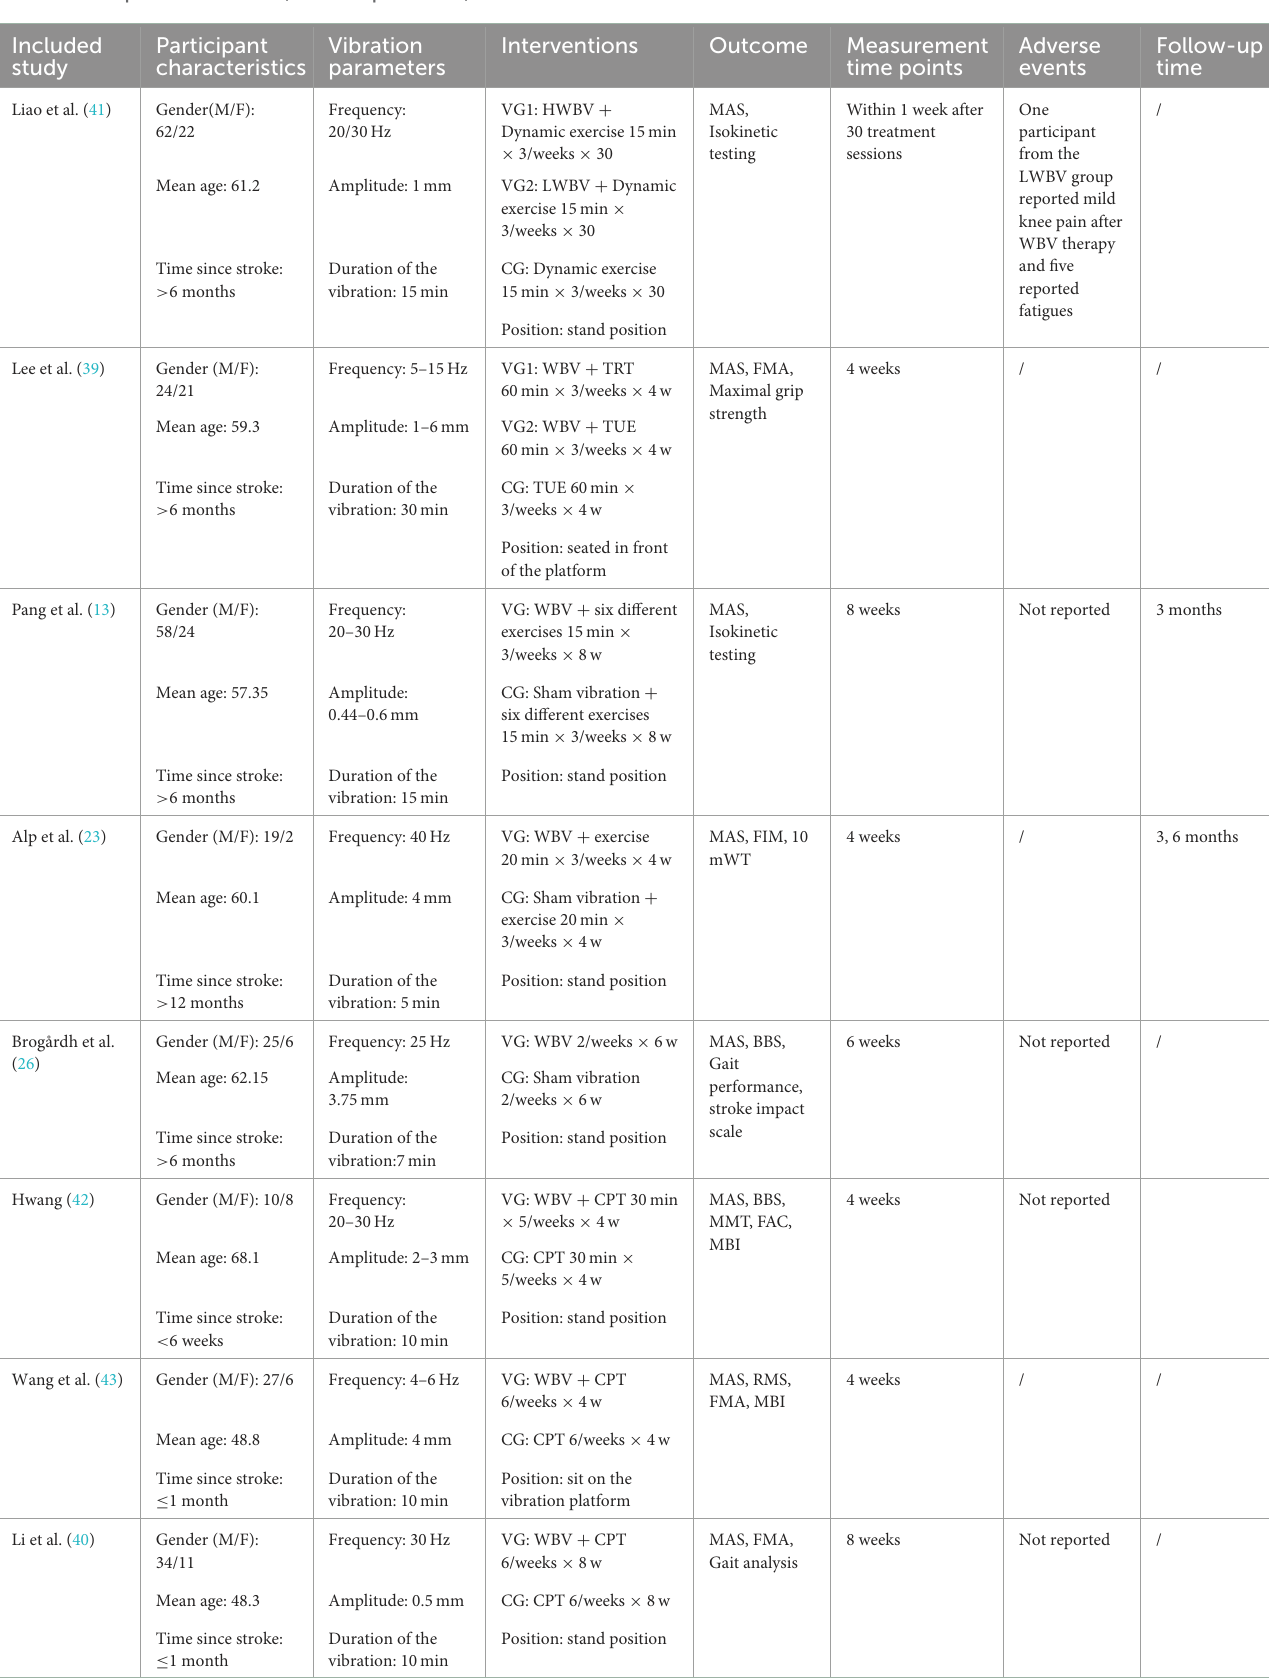
TABLE 2 Participant characteristics, vibration parameters, and interventions. Included Participant Vibration study characteristics